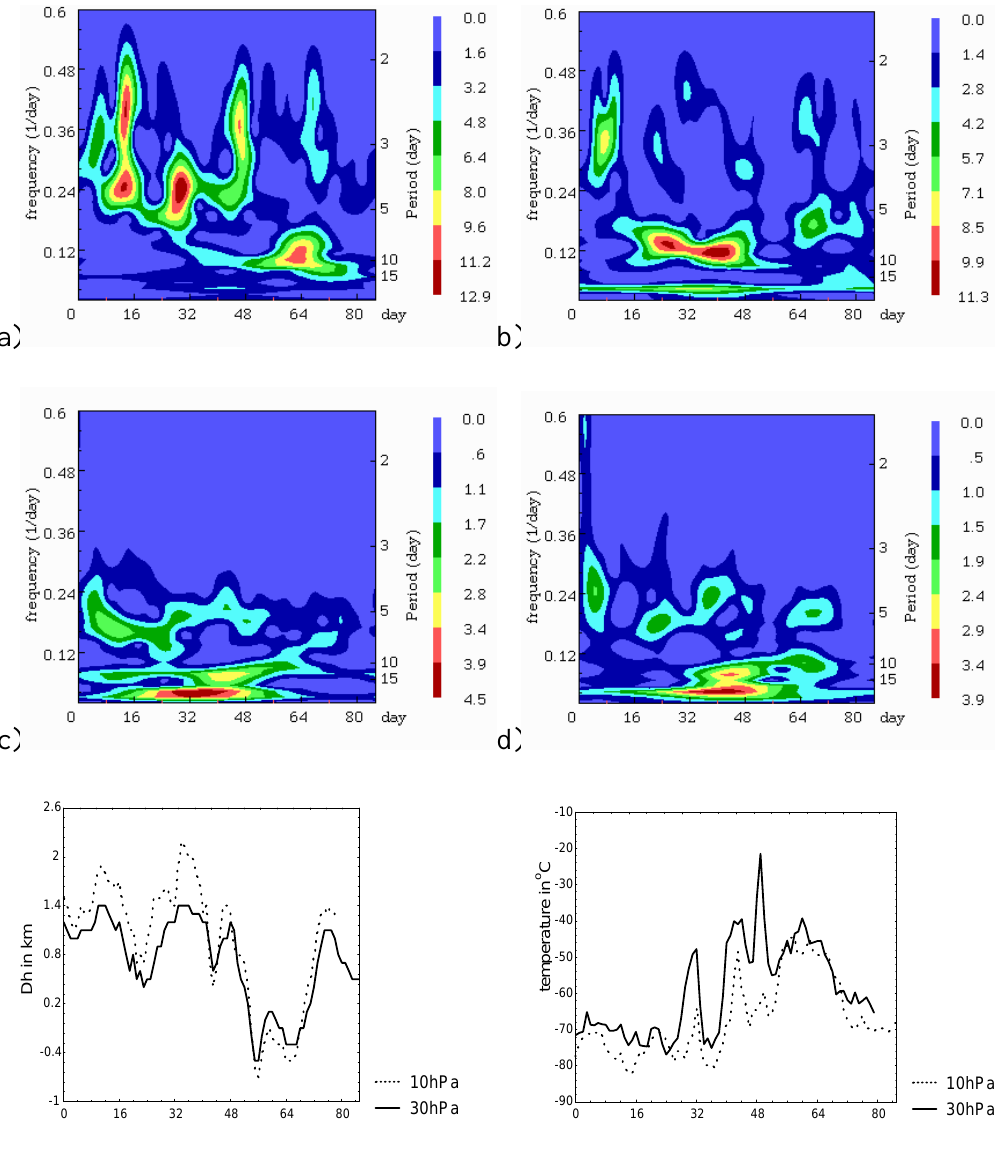
Fig. 8. Cross S-transform spectrograms of the winter 1990–1991 campaign for the mean winds ( a and b ) and for semidiurnal tide amplitudes ( c and d ). At the bottom the depth of the polar vortex (left) and the polar temperature (right) are shown at two height levels: 10 hPa and 30